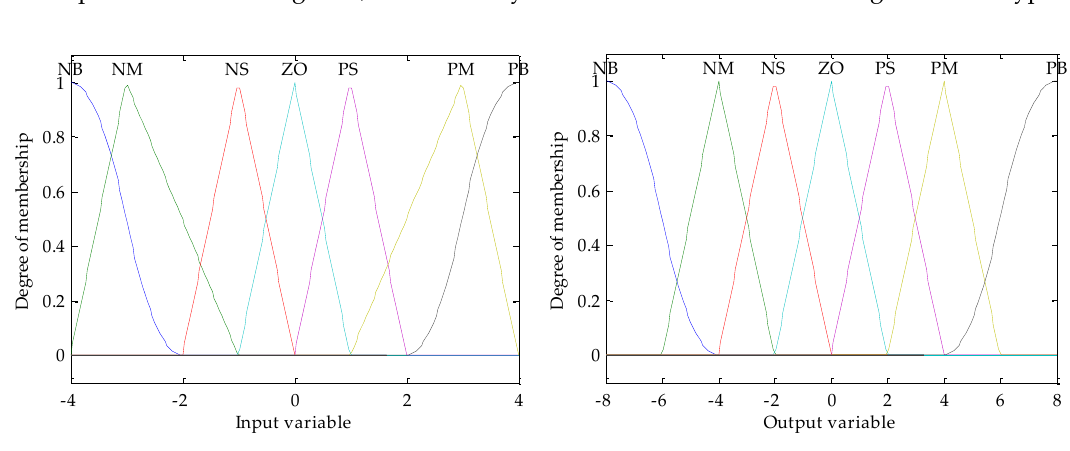
Figure 9. Types of membership function of input and output variables. Table 5. Fuzzy control rules for input variable ss .